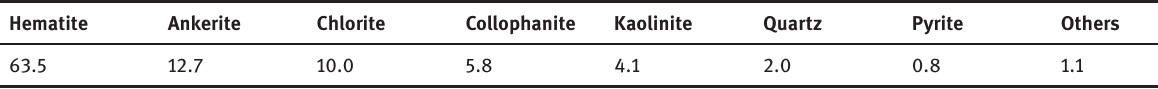
Table 4: Various Fe mineral phases (distribution) within the oolitic iron ore. Mineral Magnetite Hematite/Limonite Siderite Ferric silicate Sulphide ores Total Fe Fe content (%) 0.06 44.66 Distribution (%) 0.12